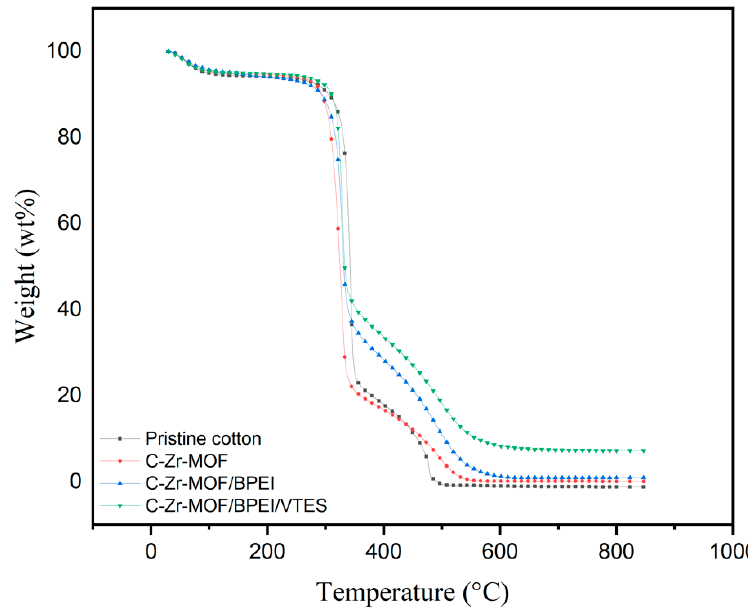
Figure 6. TGA curves of pristine cotton and treated samples. Table 1. TGA data of pristine cotton and treated samples under air